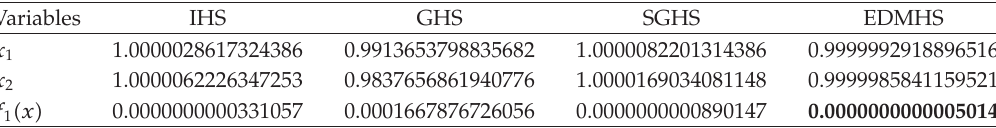
Table 1: Four HS algorithms for Rosenbrock function.